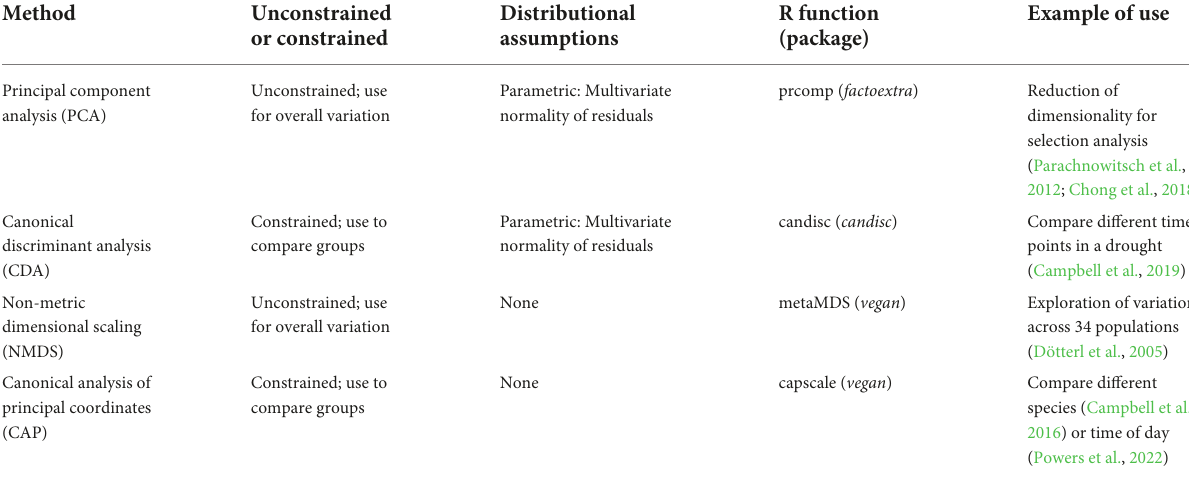
TABLE 1 Four categories of ordination methods for analyzing multivariate data, along with descriptions of whether the method is unconstrained or constrained, when to use it, distributional assumptions, R functions and packages, and examples of